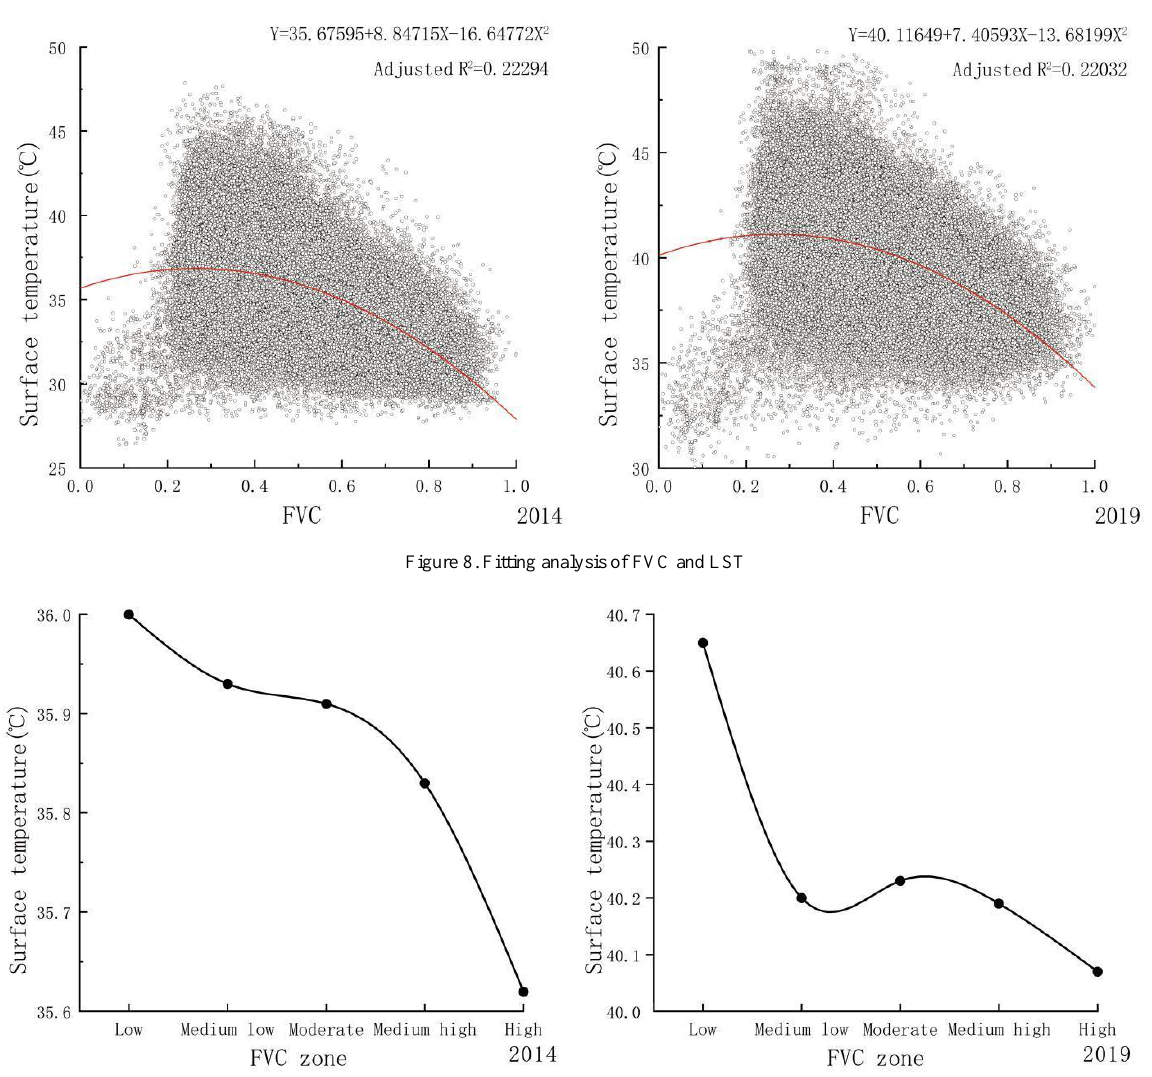
Figure 9. Average LST in different FVC